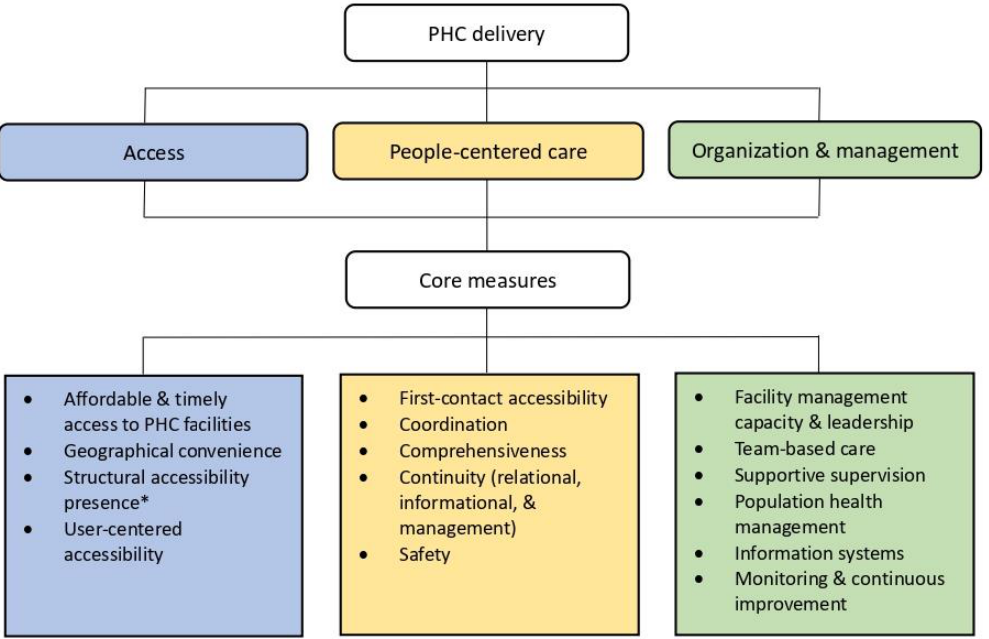
Figure 2. Framework of searches and syntheses, compiled by the authors from the literature [24]. * “ Structural accessibility presence ” is a dimension used to examine accessibility issues, with a primary focus on the availability of structural elements such as facilities and human resources (e.g., Is there a facility with a provider available for care when it is needed by the community?) [24]. Abbreviation: PHC — primary health care.